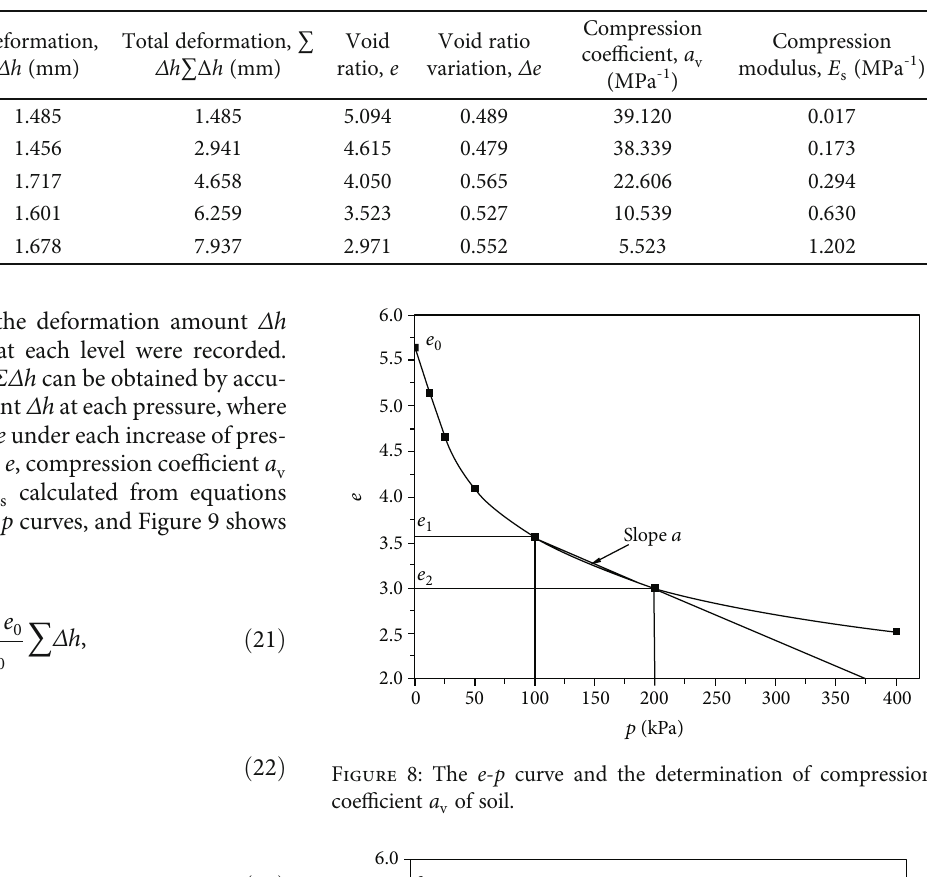
Table 5: Consolidation test parameters.